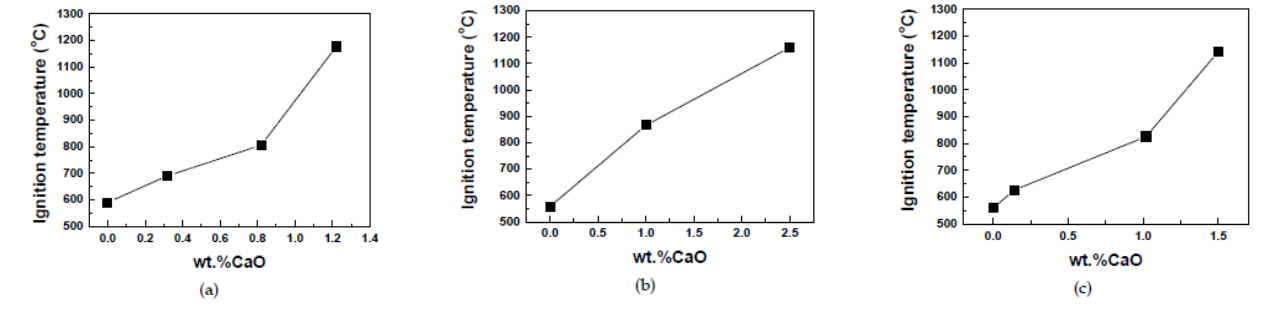
Figure 2. Increase in ignition temperature of Mg with increasing addition of CaO. ( a ) AZ31; ( b ) AM60; ( c ) AZ91. Reproduced with permission from [4].